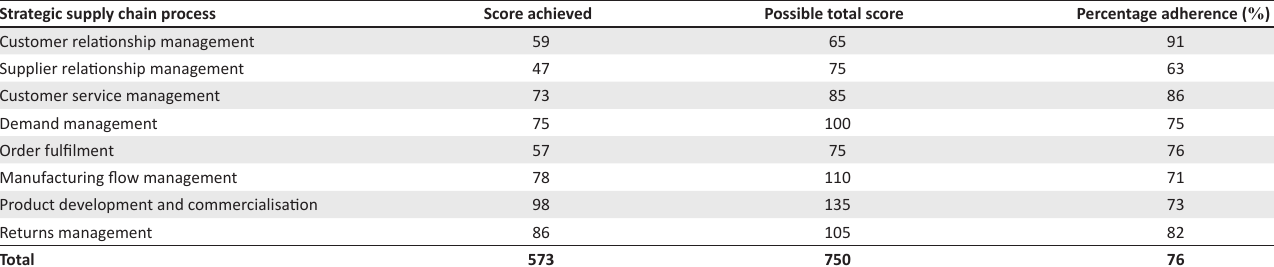
TABLE 2: Scores and percentage adherence achieved per strategic supply chain process according to the Global Supply Chain Forum benchmarking framework. Strategic supply chain